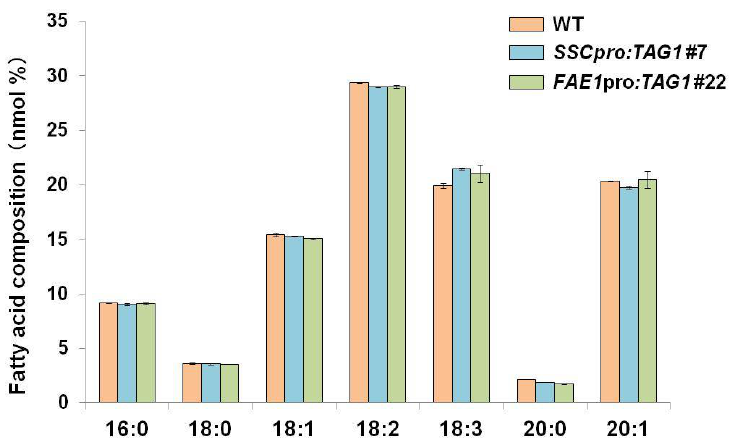
Figure 6. Fatty acid (FA) composition in seeds from transgenic plants. As representatives, FA compositions of seeds from transgenic lines that accumulated the highest amounts of TAG; lines SSCpro:TAG1 #7 and FAE1:TAG1 #22 are shown compared with that of WT seeds. Values are means ± standard deviation of measurements of 3 independent experiments.